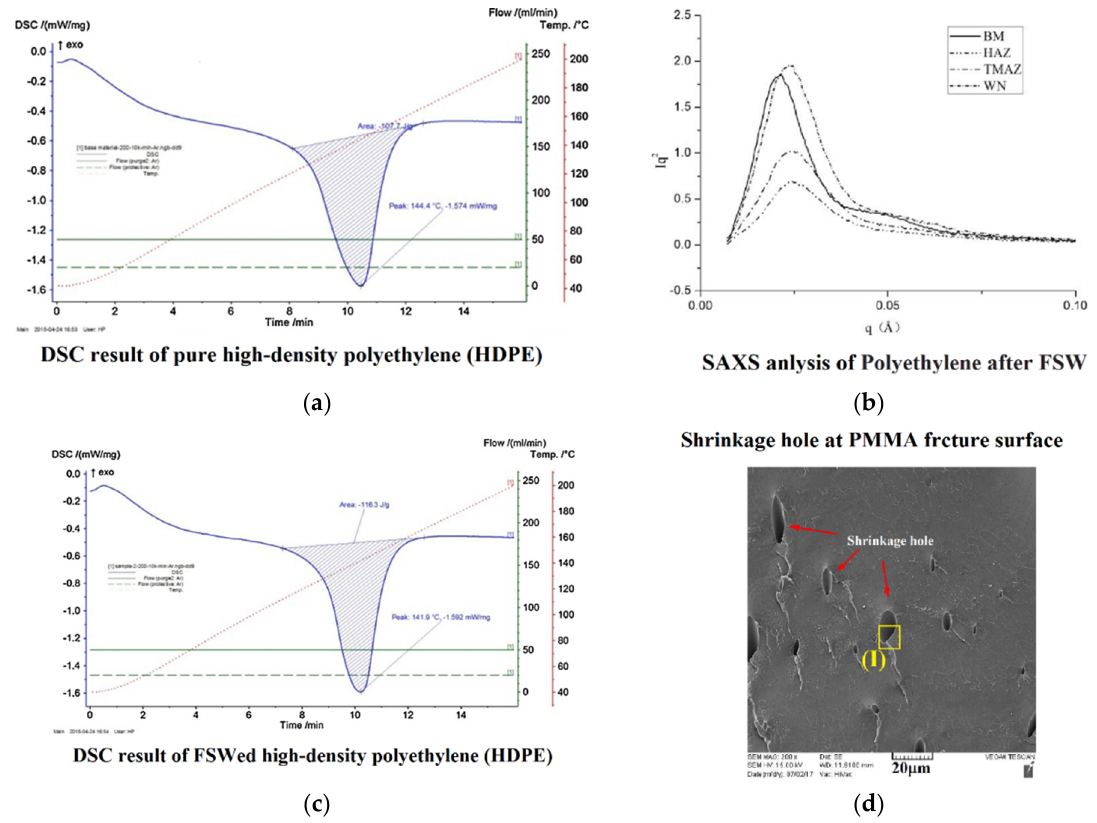
Figure 11. Differential scanning calorimetry (DSC) results of HDPE before ( a ) and after ( b ) LFSW [36], ( c ) small angle X-ray scattering (SAXS) analysis of polyethylene (PE) [37] and ( d ) shrinkage holes of PMMA on fracture surface of tensile sample [25].